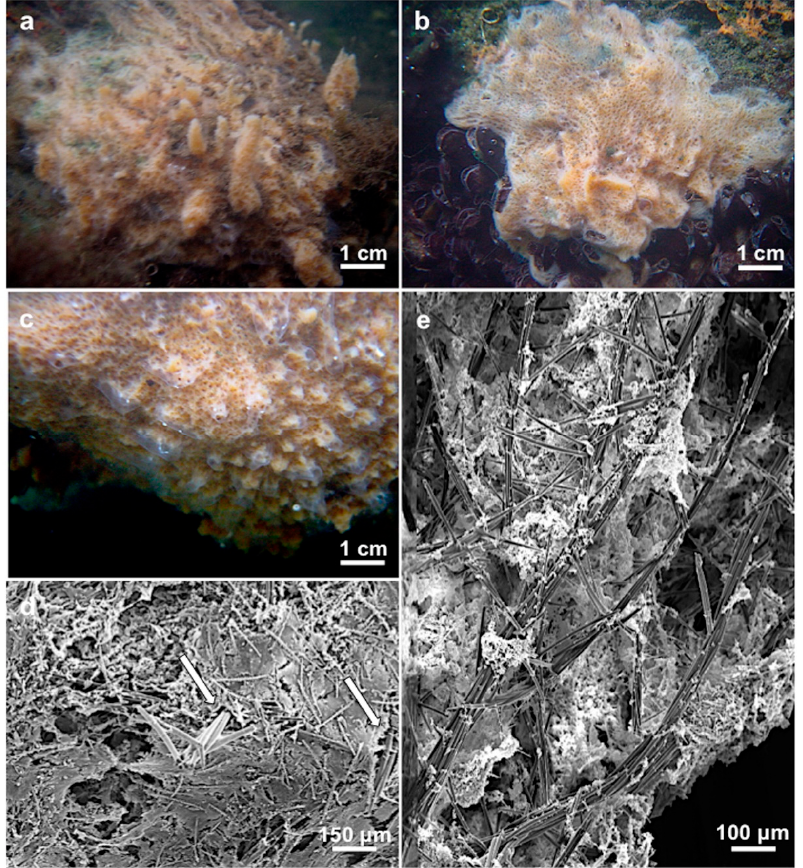
Figure 2. Spongilla manconiae sp. nov. ( a ) Holotype MSNG 61501; ( b ) Paratype MSNG 61502; ( c ) Topotype HL108; ( d ) Ectosomal skeleton with tangential spiny microxeas. Arrows indicate the spicules of the longitudinal primary fibers that protrude from the sponge surface; ( e ) Choanosomal skeletal architecture (transverse section).